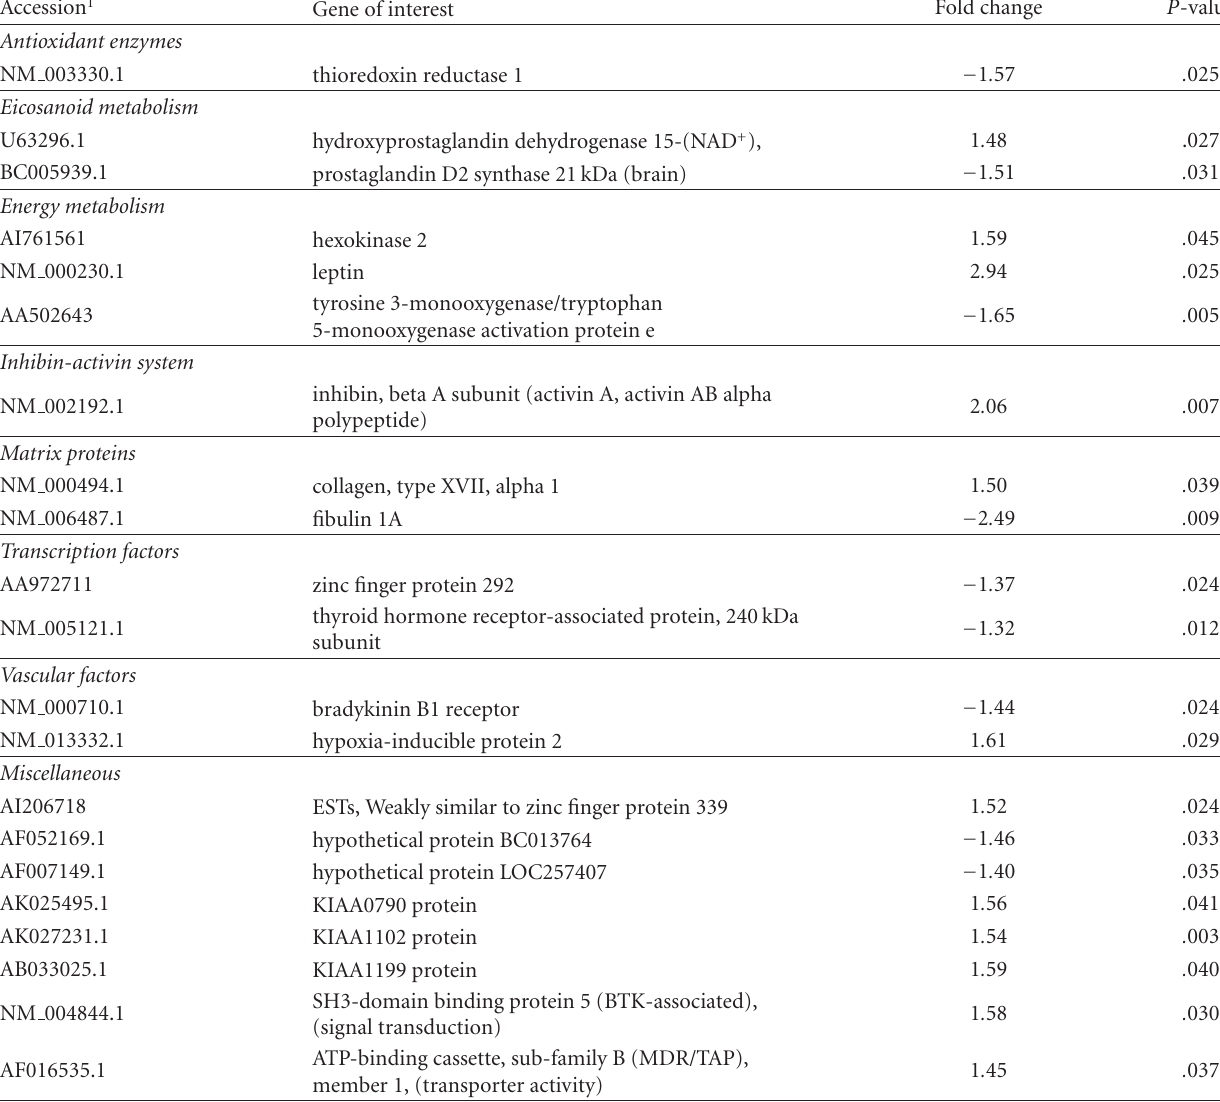
Table 3: Regulation of genes in pre-eclamptic placentas compared to